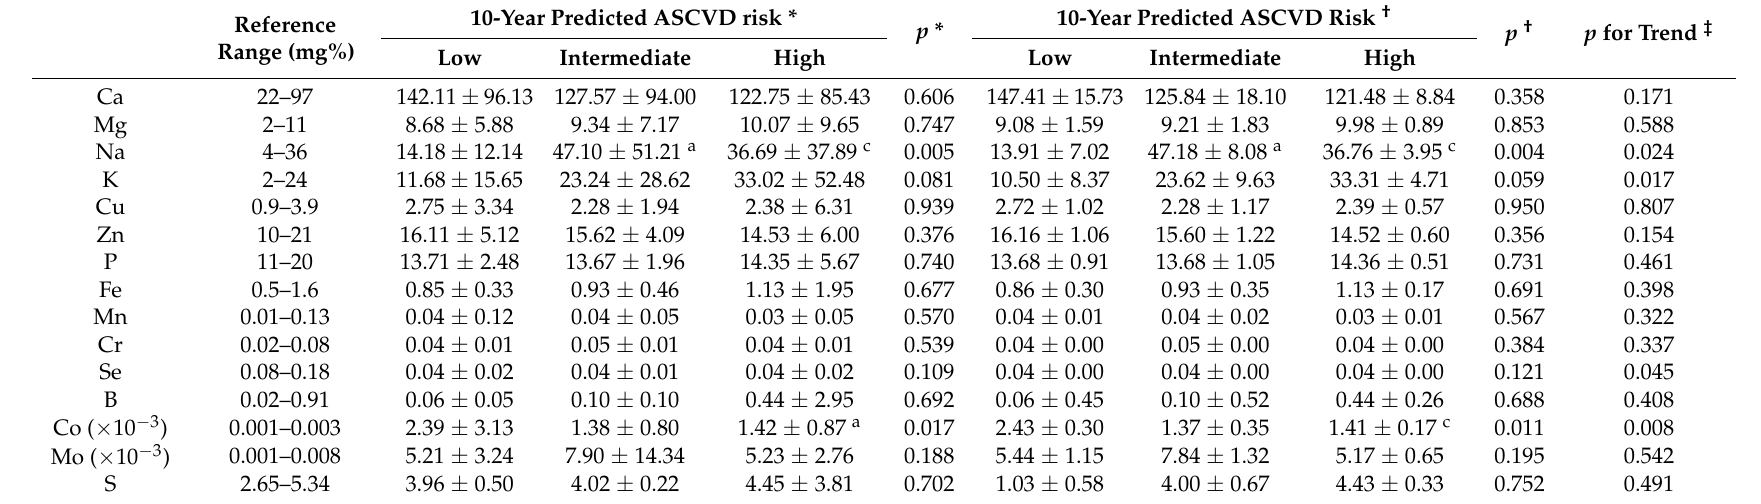
Table 2. Concentrations of fifteen nutritional elements in hair in the three groups of subjects stratified by severity of ASCVD